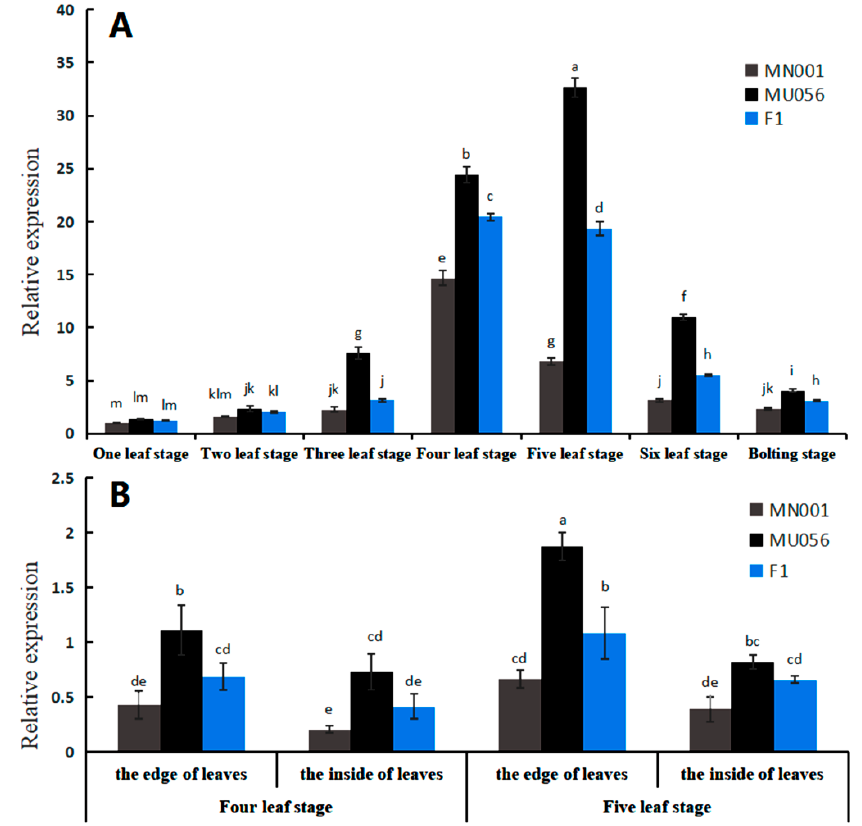
Figure 5. Tissue-specific expression of BjLMI1 gene. ( A ) Relative expression of BjLMI1 in different stages of parents and F 1 leaves measured by qRT-PCR. ( B ) Relative expression of BjLMI1 in four-leaf stage and five-leaf stage at the edge of leaves and inside leaves. Values are mean ± SD (n = 3 biological and 3 technical replicates). Letters indicate p < 0.01 (Student’s t-test).